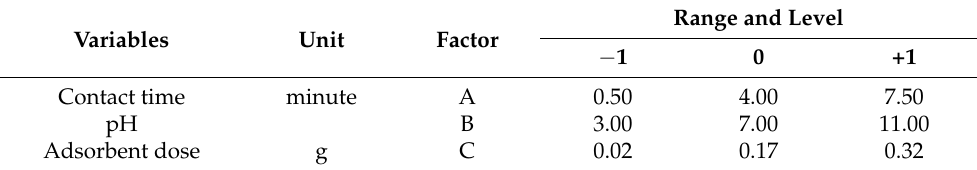
Table 6. Independent variables and their levels used for the Box–Behnken